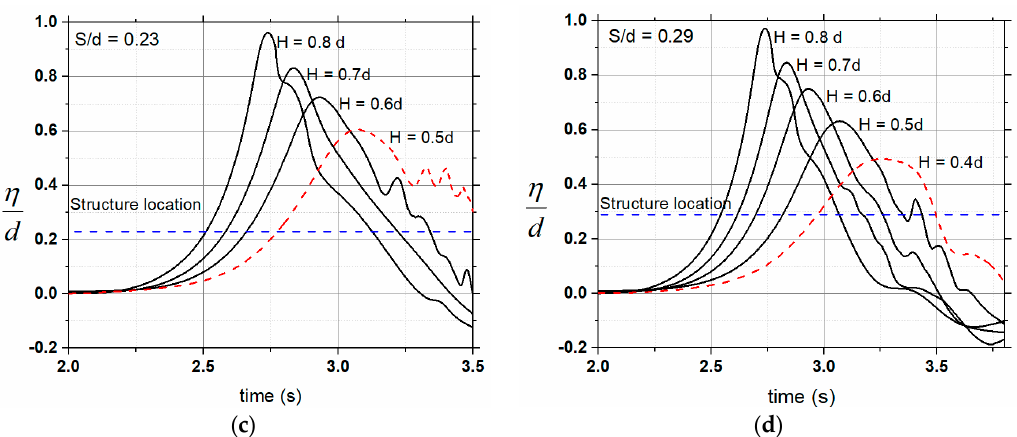
Figure 10. Wave elevation before hitting the structure at a distance, x = 4.8 m along the NWT for different normalized airgaps ( a ) S/d = 0.11 ( b ) S/d = 0.17 ( c ) S/d = 0.23 and ( d ) S/d = 0.29.